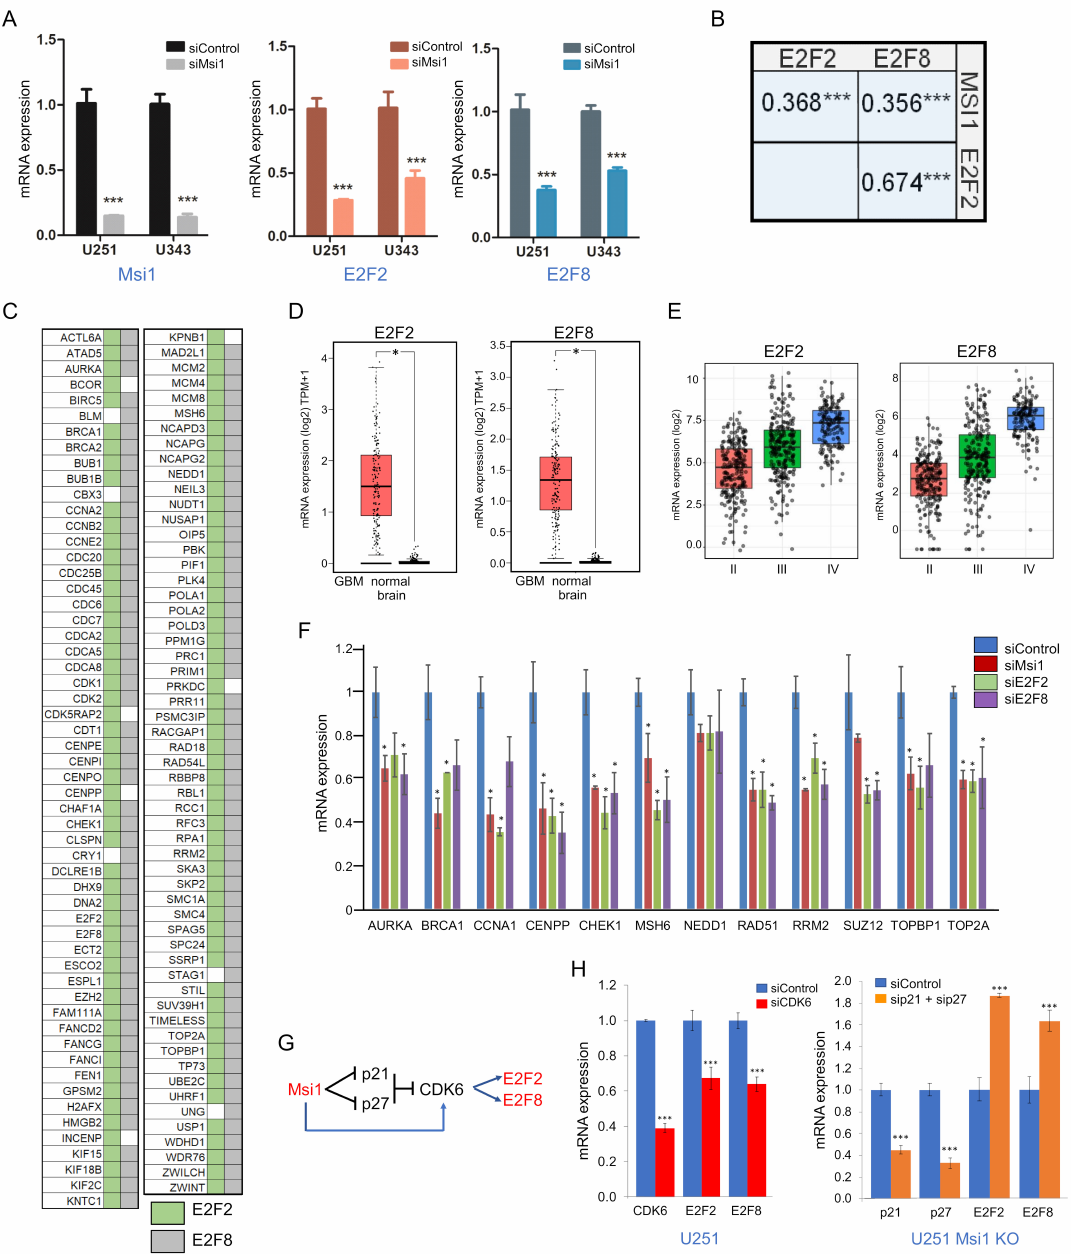
Figure 6. E2F2 and E2F8 are mediators of Msi1 impact on cell cycle and DNA replication genes. ( A ) qRT-PCR data showing that E2F2 and E2F8 decreased expression upon Msi1 knockdown in U251 and U343 cells. Statistical significance calculated by multiple t -test (*** p < 0.001). ( B ) Expression correlation (R values) between Msi1, E2F2 and E2F8 in TCGA GBM samples (*** p < 0.001). ( C ) The table shows genes affected by Msi1 KO in U251 and U343 cells that also display high expression correlation with E2F2 and E2F8 in GBM samples. Pearson correlation, all genes *** p < 0.001, R > 0.3. ( D ) E2F2 and E2F8 mRNA expression levels in normal brain vs. glioblastoma according to GEPIA [54]. ( E ) E2F2 and E2F8 mRNA expression in gliomas grades II, II and IV (TCGA samples). Data shown in B, C and E was generated with Gliovis [55]. ( F ) qRT-PCR data shows the impact of Msi1, E2F2 and E2F8 knockdown on the expression of the cell cycle, cell division and DNA replication genes in U251 cells. ( G ) Model showing that Msi1 regulates the expression E2F2 and E2F8 via CDK6, p21 and p27. ( H ) qRT-PCR data shows the impact of CDK6, p21 and p27 knockdown on the expression of E2F2 and E2F8. Left panel, CDK6 KD was performed in U251 cells. Right panel, p21 and p27 double KD were performed in U251 Msi1 KO cells. Statistical significance calculated by multiple t-test. Data shown as means ± s.d. (* p < 0.05, *** p <